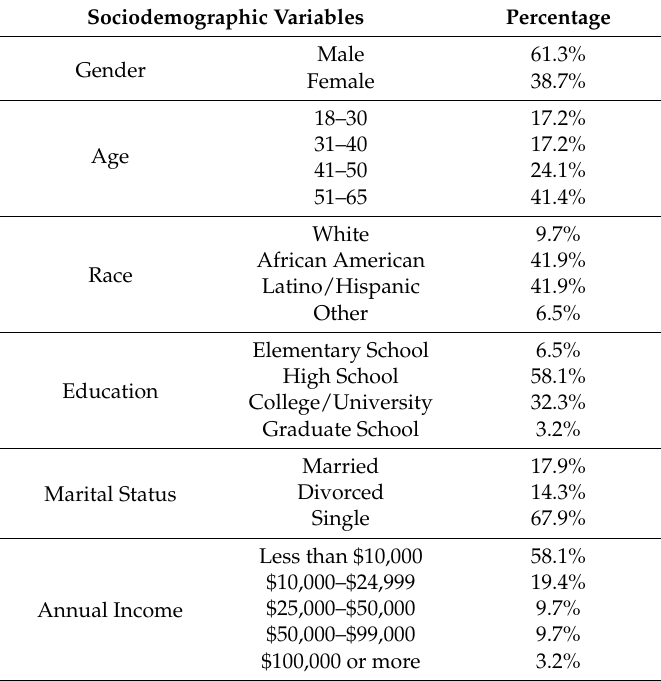
Table 1. Sociodemographic characteristics of the participants in this